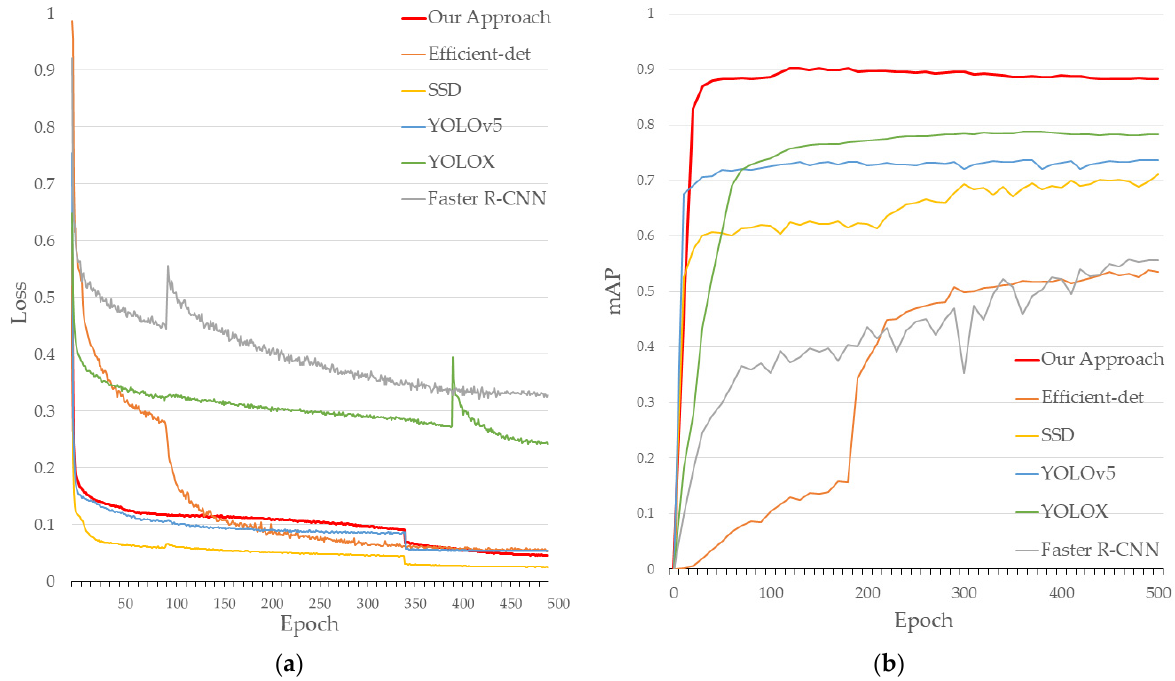
Figure 13. Iterative trends of ( a ) loss function convergence curves and ( b ) mAP for each model after 500 epochs of training. It should be noted that compared networks use different loss functions. Table 5. Results of ablation experiments using the same dataset, where bold numbers indicate the highest mAP, and “ √ ” in each column indicates that the leftmost component is used in the model. The last number in each column represents the mAP obtained using the corresponding component.